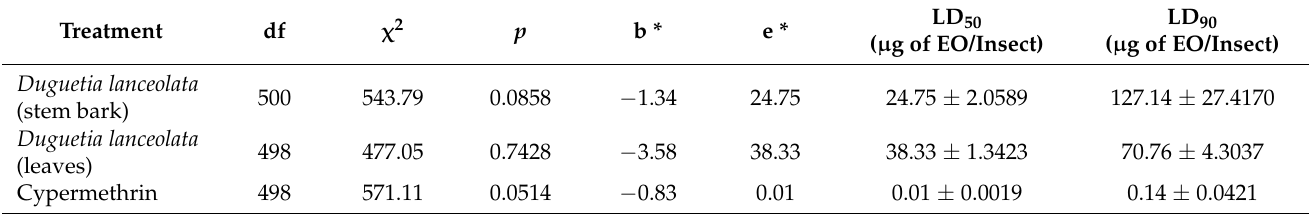
Table 3. Dose-mortality response of caterpillars of Spodoptera frugiperda treated with essential oils from the leaves and stem barks of Duguetia lanceolata and the active ingredient cypermethrin.